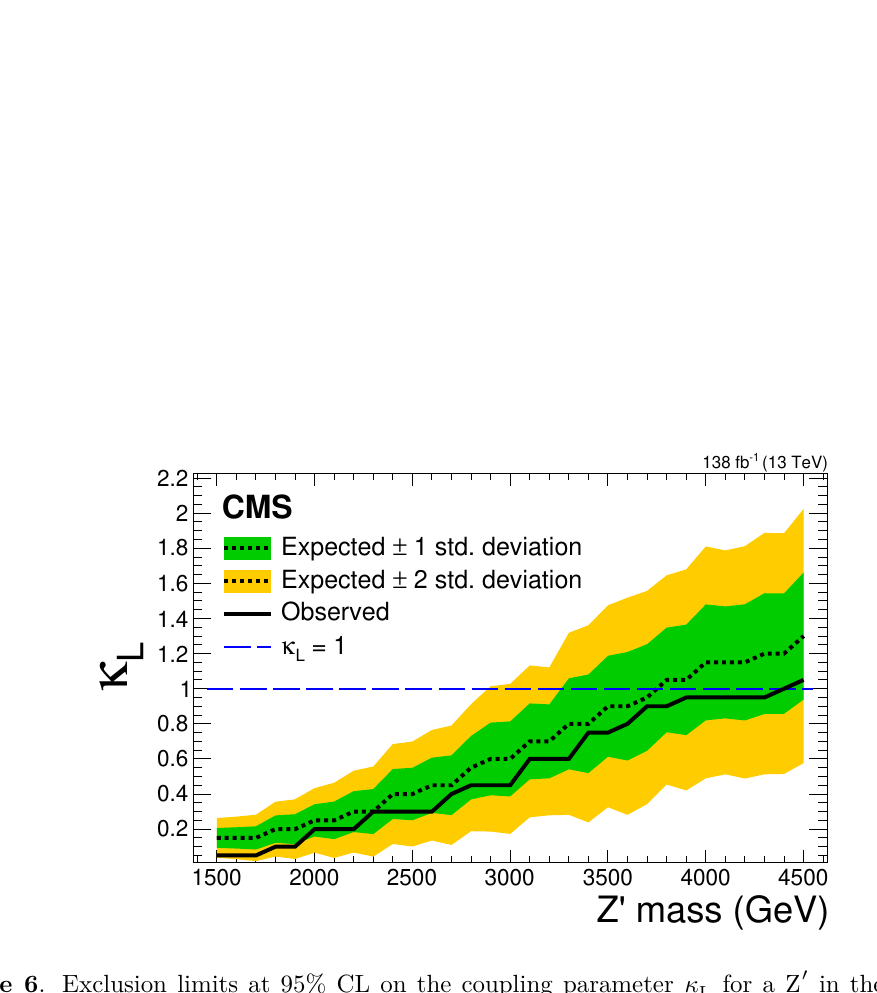
Figure 6 . Exclusion limits at 95% CL on the coupling parameter κ standard model as a function of the Z 0 mass. The expected (observed) limit is shown by the dashed (solid) line. The inner and outer shaded areas around the expected limits show the 68% (green) and 95% (yellow) CL intervals, respectively. The dashed blue line shows κ to a Z 0 with exactly the same couplings as the SM Z